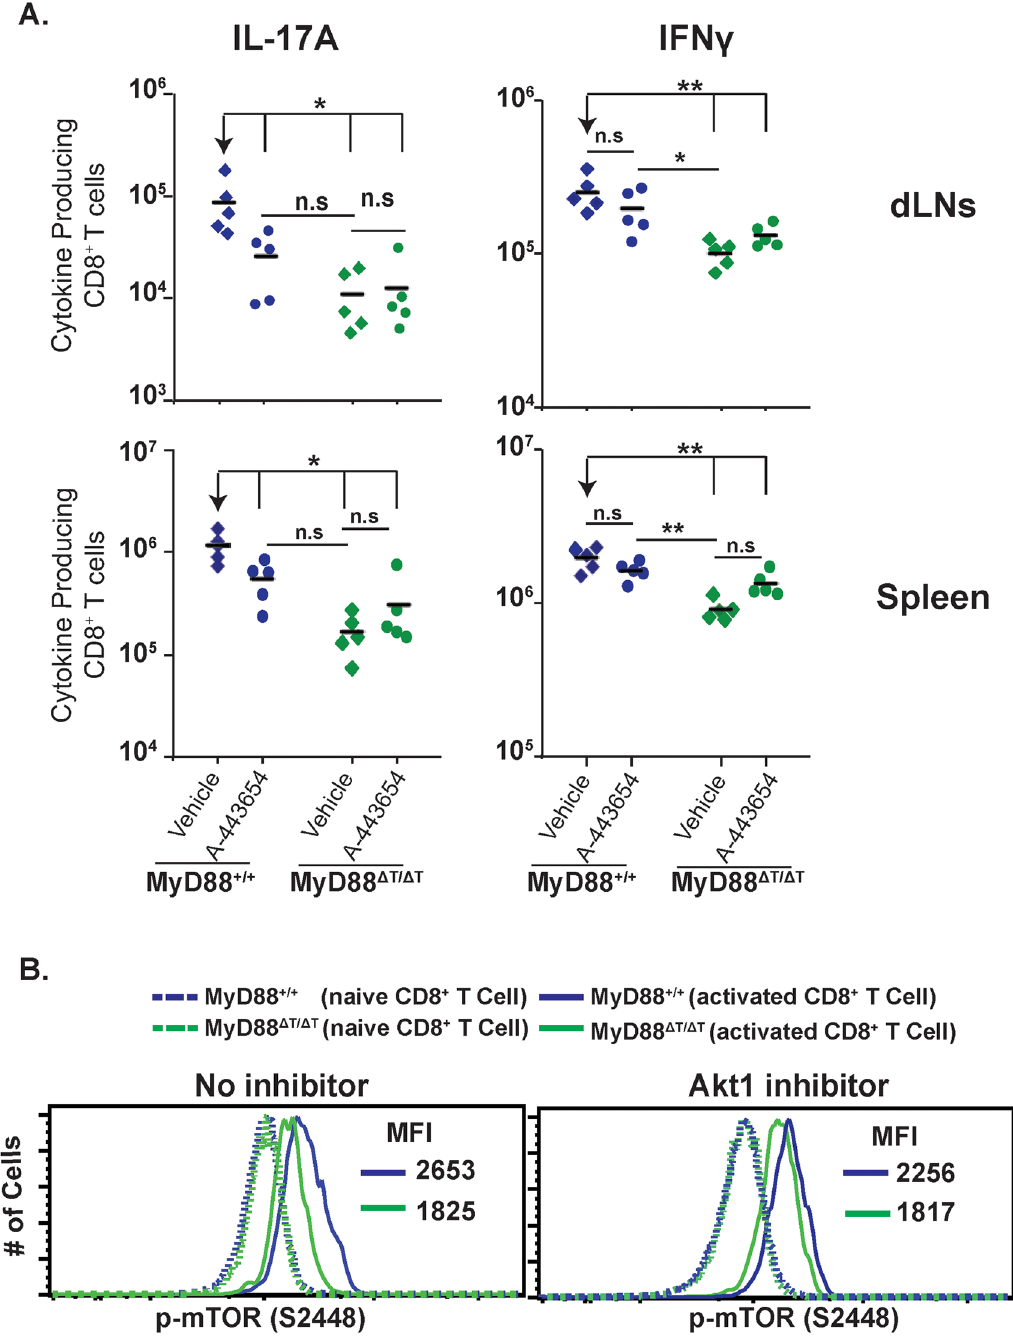
Fig 7. MyD88 requires Akt1 signaling for mTOR activation. A . Mice were CD4+ T cell depleted and vaccinated with strain #55. Akt1 inhibitor (A-443654) was administered s.c. from day 4 to 15 post-vaccination. On day 16, dLNs and spleen cells were collected, restimulated and stained for surface markers and intracellular cytokines. Numbers of IL-17A and IFN γ producing CD8 + T cells were analyzed by flow cytometry. A diamond represents an individual mouse and the bar is the mean of the group. * p (cid:1) 0.05 and ** p (cid:1) 0.01. Data is representative of 2 independent experiments. B . Purified naive WT and MyD88 Δ T OT-I cells were stimulated in vitro with anti-CD3 and yeast-stimulated BMDC supernatant. On day 4, supernatant was removed and replaced with culture medium. Cells were rested for 2.5 hours and medium was replaced with yeast stimulated BMDC supernatant either with or without Akt1 inhibitor (1 μ M) for 1 hour. Cells were surface stained prior to phospho-staining. Values in the histograms represent mean fluorescence intensity (MFI) of p-mTOR. Data in solid lines are from gating on activated cells (CD8 + CD43 + CD44 hi CD62L lo ), whereas data in dotted lines are from gating on na ï ve cells (CD8 + CD43 neg CD44 lo CD62L hi ).